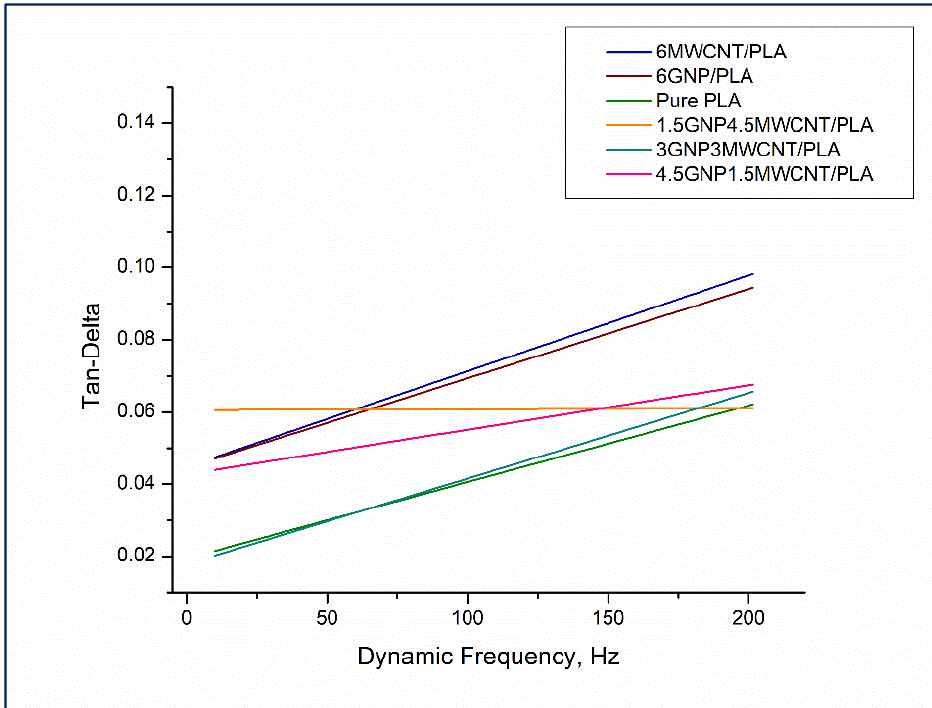
Figure 10. Tan δ versus dynamic frequency for the whole series of nanocomposite samples including neat PLA.